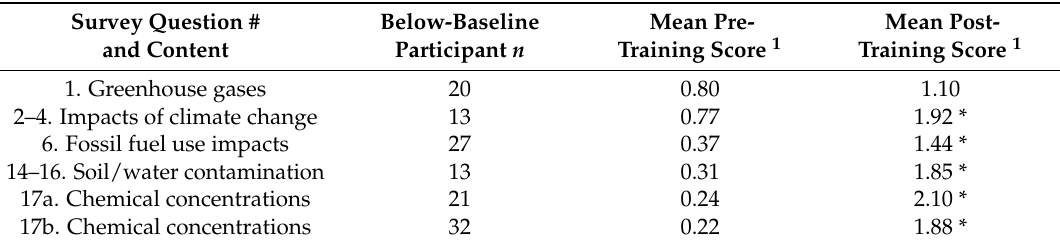
Table 6. Level of environmental science knowledge in “below-baseline pre” participants only.